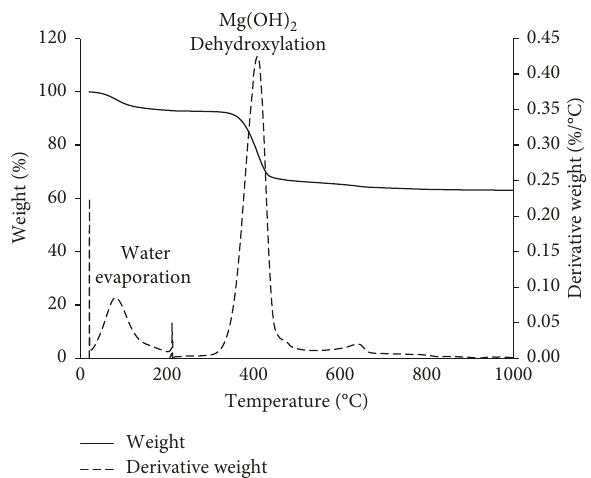
Figure 4: TG and DTG of magnesia paste activated with NaSO